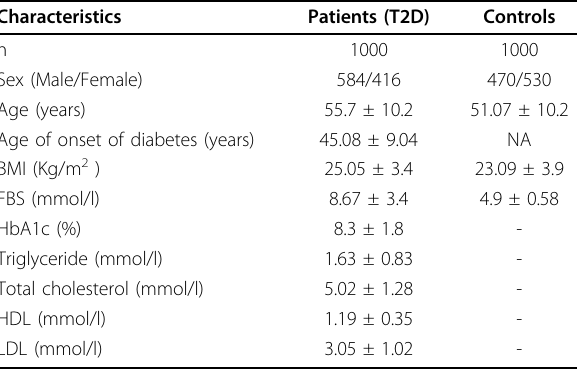
Table 1 Clinical characterisation of the study population